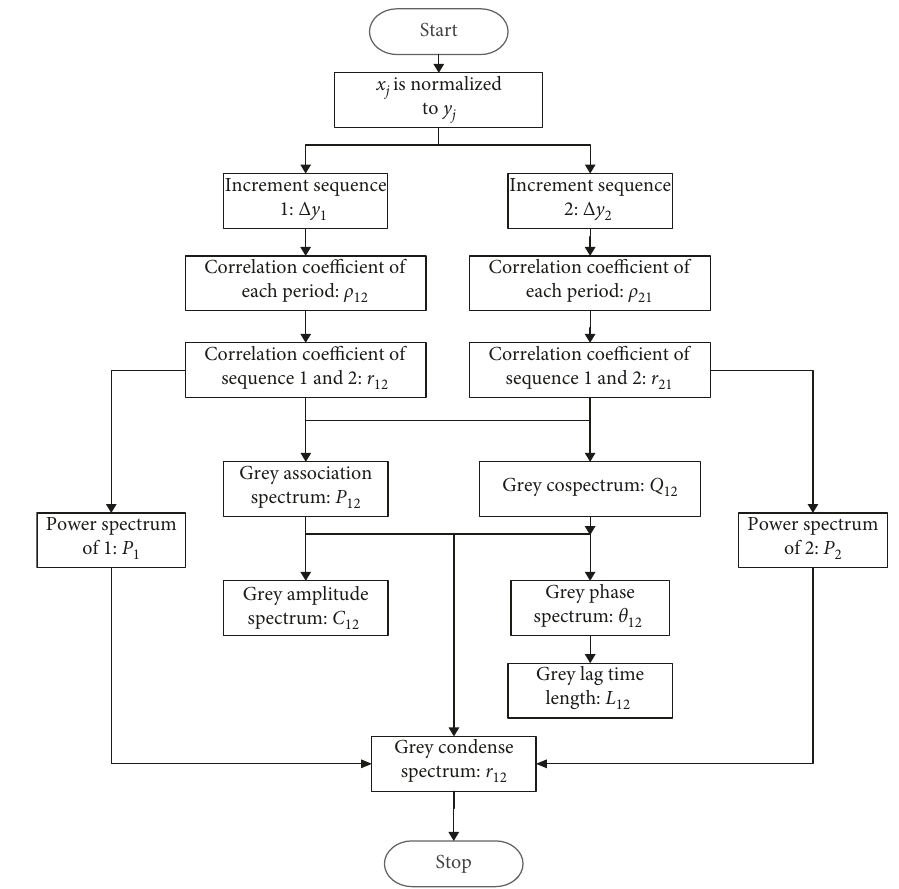
Figure 4: Flowchart of grey spectrum